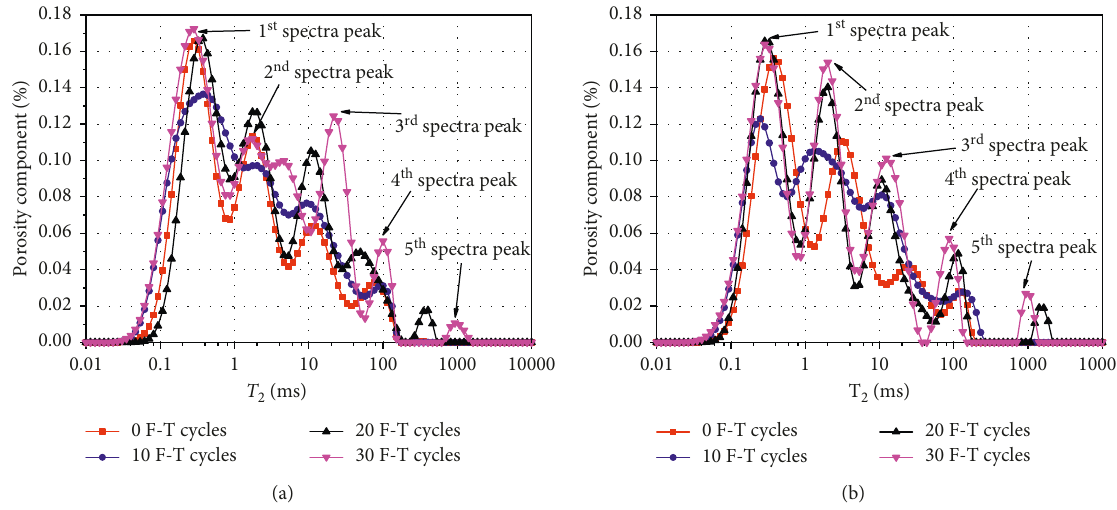
Figure 6: T 2 distribution of sandstones after different numbers of freeze-thaw cycles: (a) H 2 SO 4 solution; (b) pure water. Table 2: Statistics of the proportion of each peak area in the T